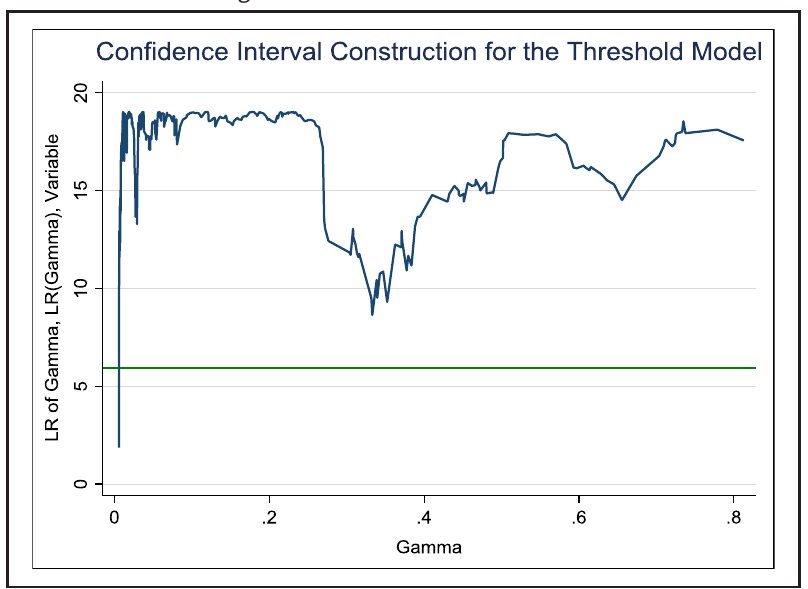
LR statistic of a single threshold